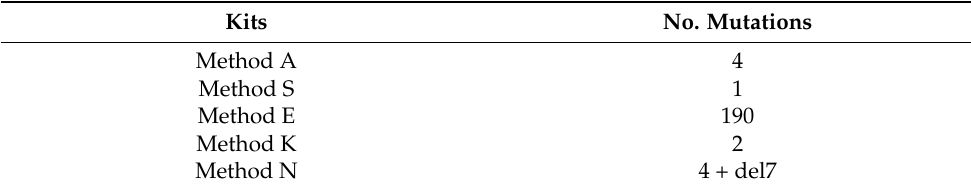
Table 5. The total number of sequence variations across the virus genome per kit. The single nucleotide variations generated by each kit when evaluated against the reference sequence generated on the Illumina MiSeq are listed; del7; a deletion of seven